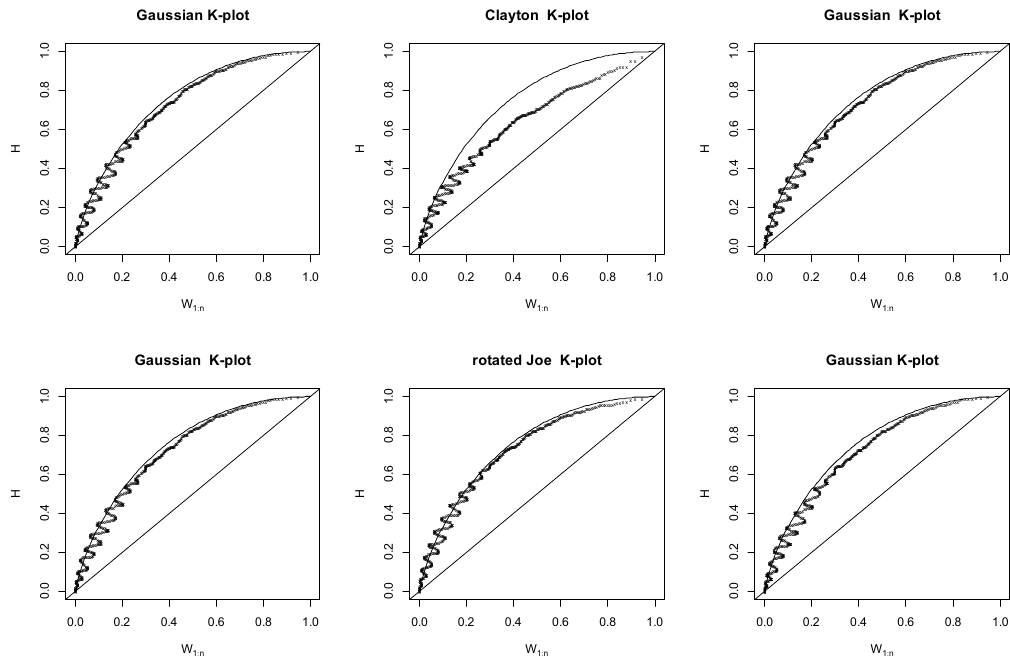
Figure 9. K-plots of pair flood volume variables of Zhangjiashan and Xianyang.